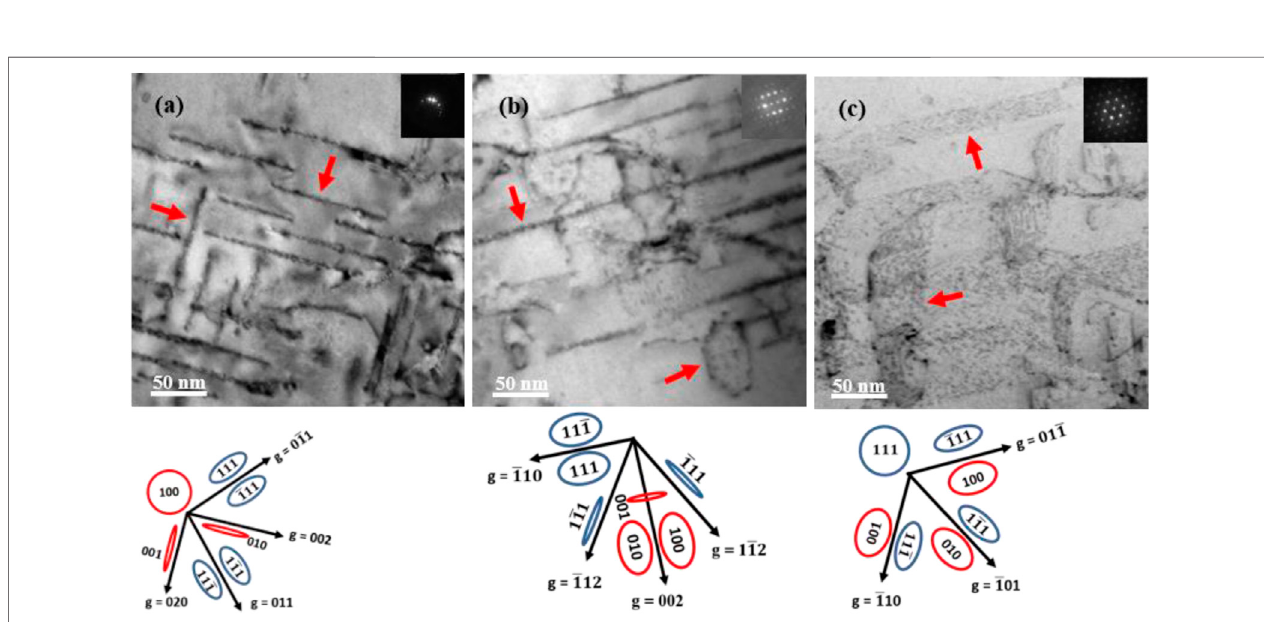
FIGURE 6 | STEM BF images showing bubble-loop complexes: (A) under < 100 > zone axis, (B) under < 110 > zone axis, and (C) under < 111 > zone axis; the red arrows indicate bubble-loop complexes.